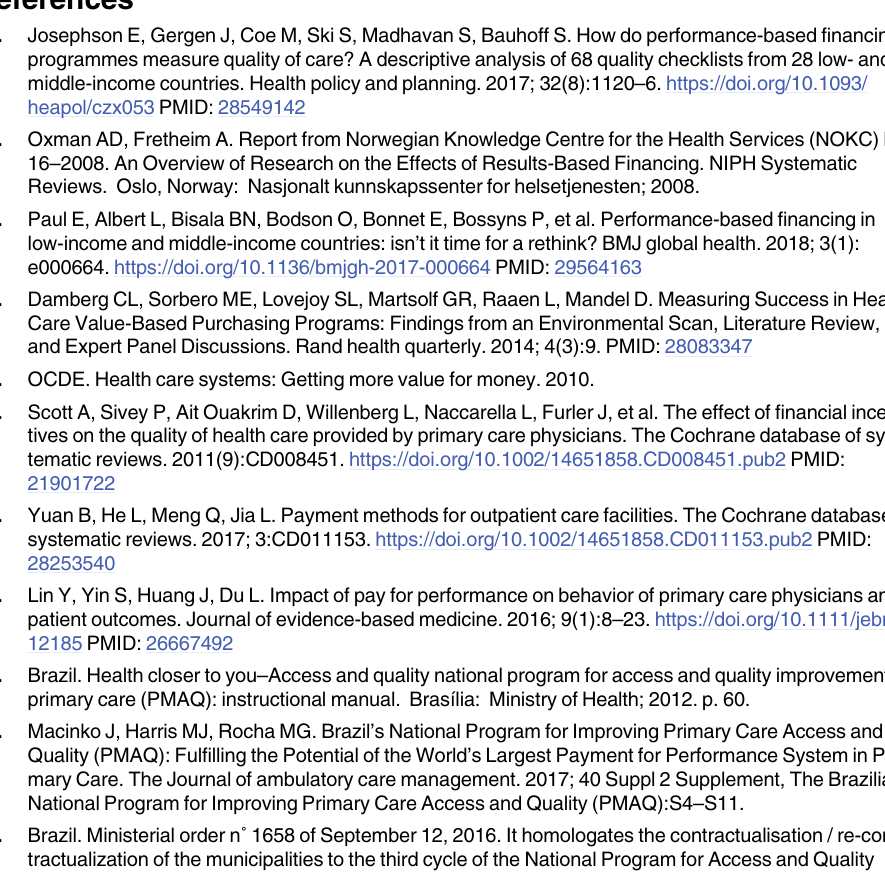
S10 Table. Results from OLS and QR models for the number of physician